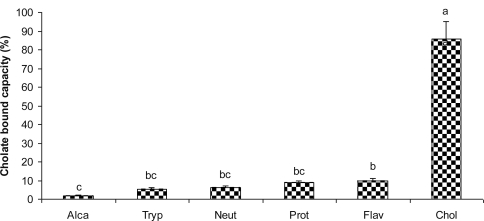
Sodium cholate binding by peptides from five differents hydrolysates of defatted corn protein. Alca: Alcalase; Tryp: Trypsin; Neut: Neutrase; Prot: Protamex; Flav: Flavourzyme. Cholestyramine (Chol) was used as a positive control. Different letters indicate significant differences (p < 0.05).